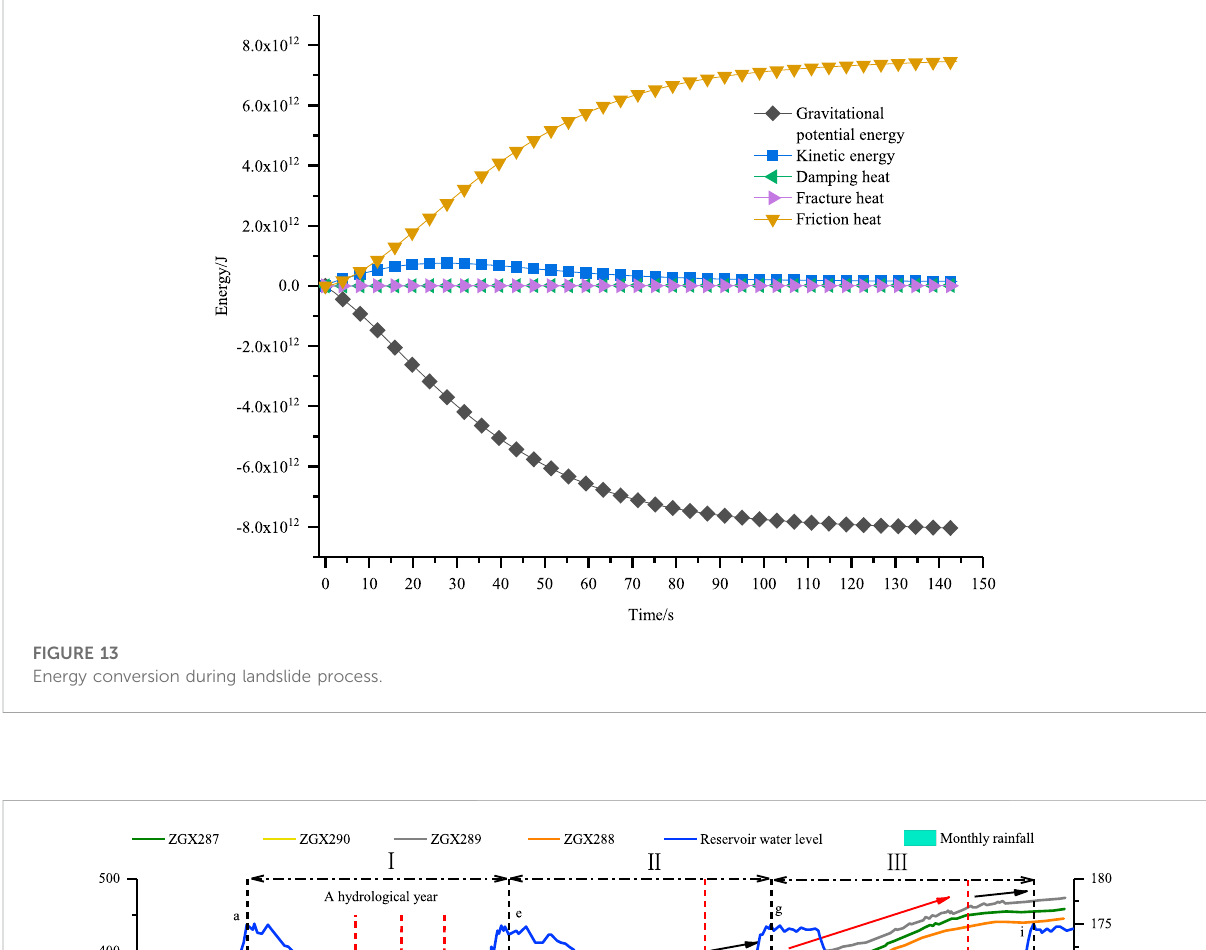
FIGURE 13 Energy conversion during landslide process.